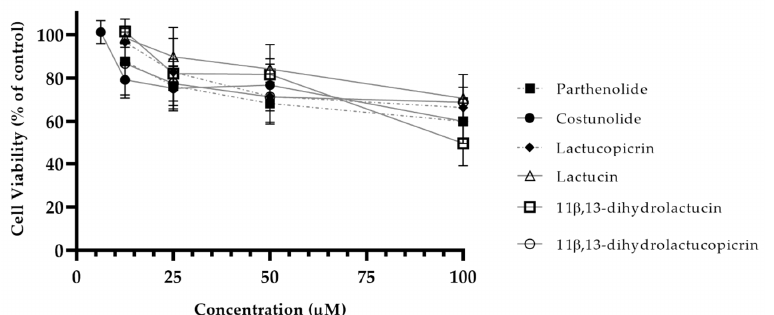
Figure 4. Cytotoxicity of chicory SLs in yeasts. Yeast cells were incubated with different concentrations (6.25–100 μ M) of SLs to determine the highest nontoxic concentration. Cell viability for each compound was determined using the Cell Titer Blue assay. Data are presented as means ± SD, n = 3.